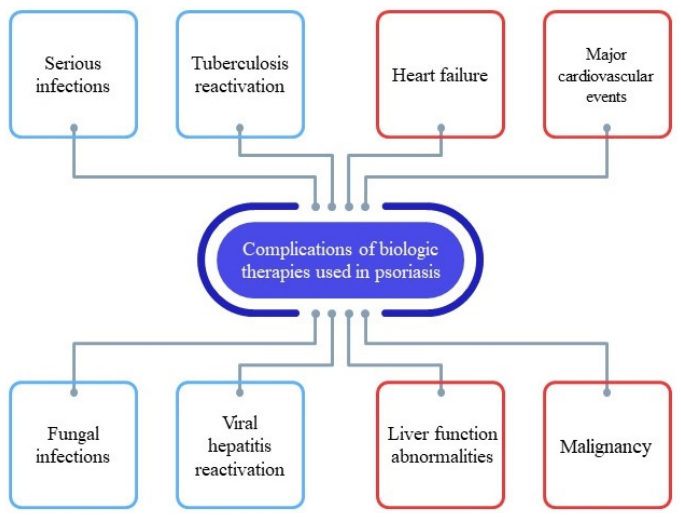
Table 2. Preferred and contraindicated biologic agents in the management of psoriasis in patients with concomitant